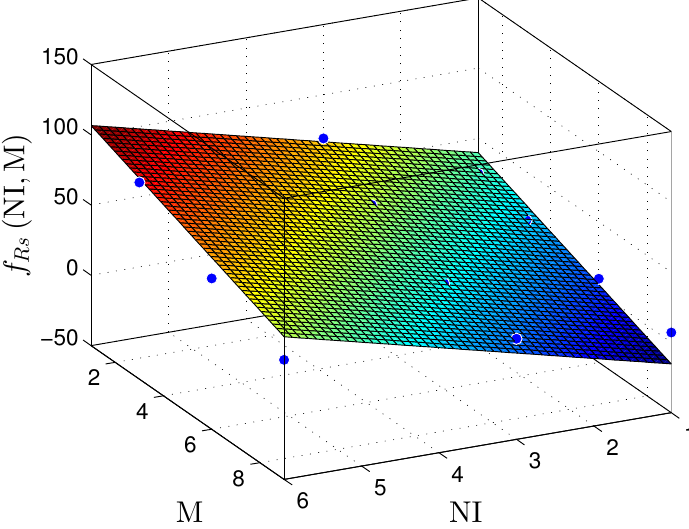
( NI , M ) that estimates the throughput, R s , as a function of NI and M, for the Figure 18. Plane f R s linear regression prediction